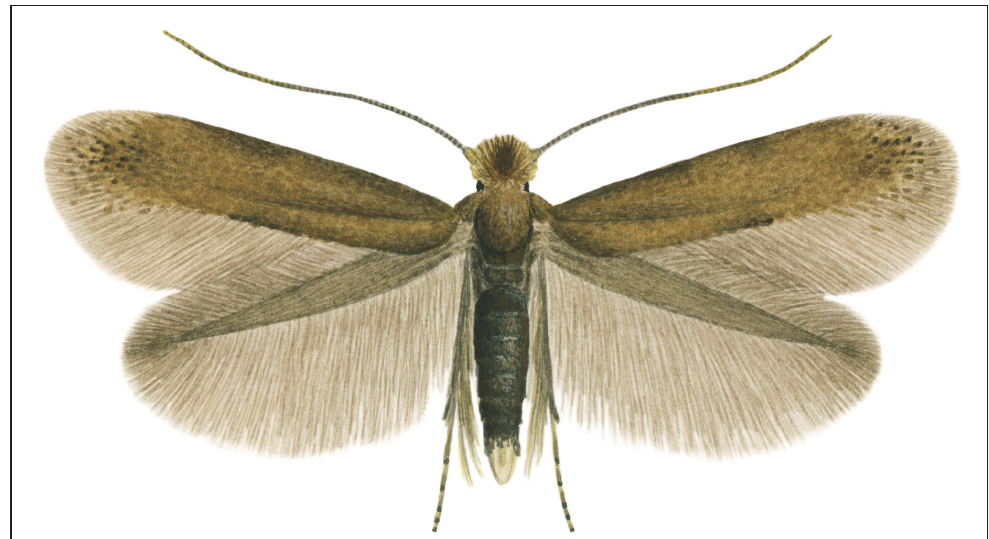
Figure 1. Bucculatrix brunnella sp. n., male, holotype, Francavilla di Sicilia, 23.vi.2000, wingspan 7.5 mm.